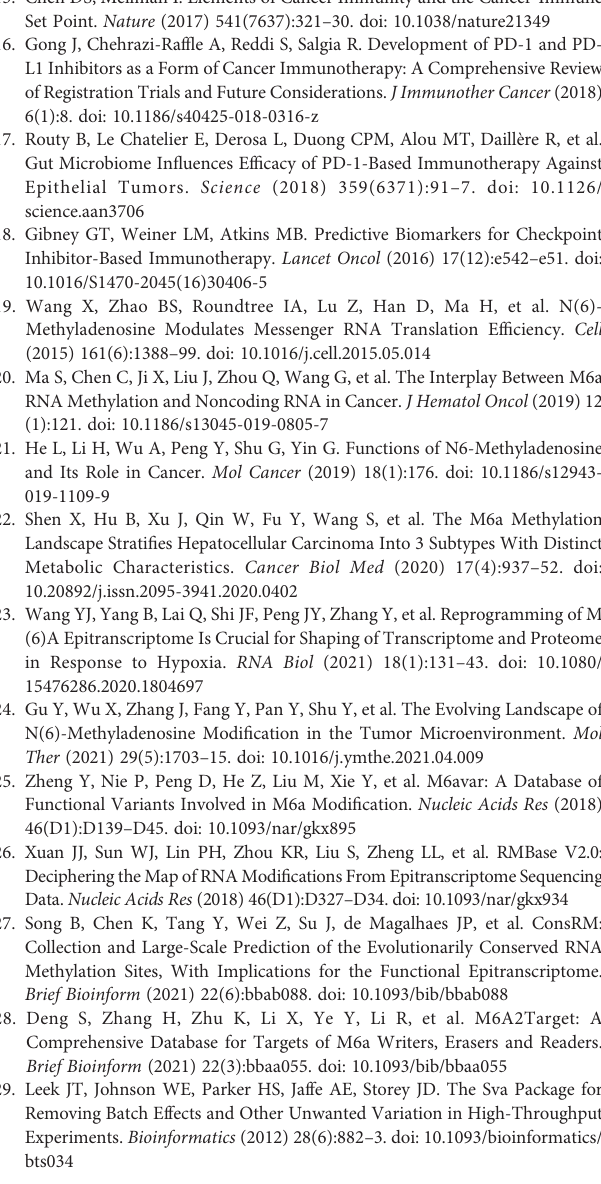
95% CI were 0.66 (57.27% - 74.76%, 95%CI), 0.64 (56.35% - 72.46%, 95%CI), and 0.64 (55.95% - 71.49%, 95%CI) at 3, 5, and 7 years respectively. (H) AUC for riskscore, stage and nomogram attained 0.646, 0.704 and 0.727, respectively, according to the m6Ascore. (I – K) Kaplan – Meier curves to show the OS difference were depicted on training cohort, testing cohort, and the entire cohort (P<0.0001, log-rank test). Supplementary Figure 4 | Decision tree. (A) Simulating clinical decision of ACRG cohort subtypes. (B) Alluvial diagram was performed on hypoxiaCluster, m6Ascore, ACRG subtypes, decision cluster result, and risk clusters to analyze the mutual connection. (C) Kaplan – Meier curves for the decision cluster result from the ACRG decision tree. (D) Simulating clinical decision of Singapore patient cohort subtypes. (E) Alluvial diagram was performed on hypoxiaCluster, m6Ascore, Singapore patient, decision cluster result, and risk clusters to analyze the mutual connection. (F) Kaplan – Meier curves for decision cluster result from Singapore patient decision